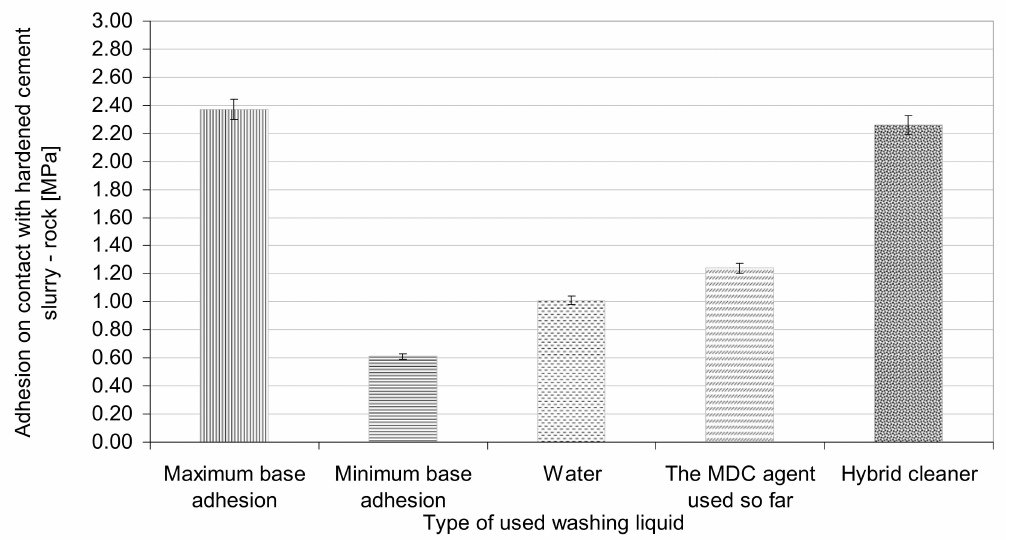
Figure 12. Adhesion to contact between hardened cement slurry and rock for various washing liquids at a delivery rate of 11.2 L/min; contact time of the washing liquid, 4